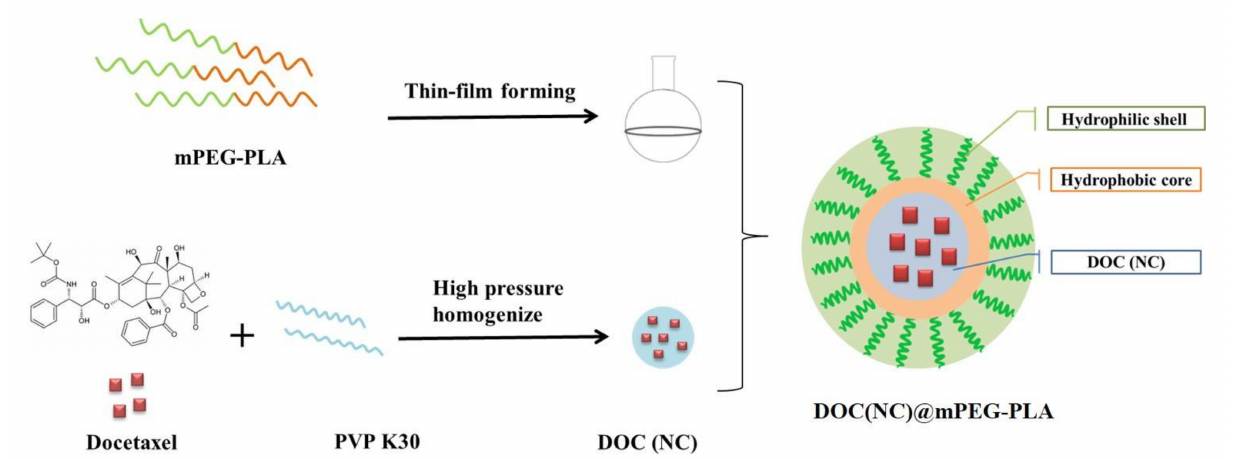
Figure 1. The preparation scheme of docetaxel nanocrystal-loaded micelles